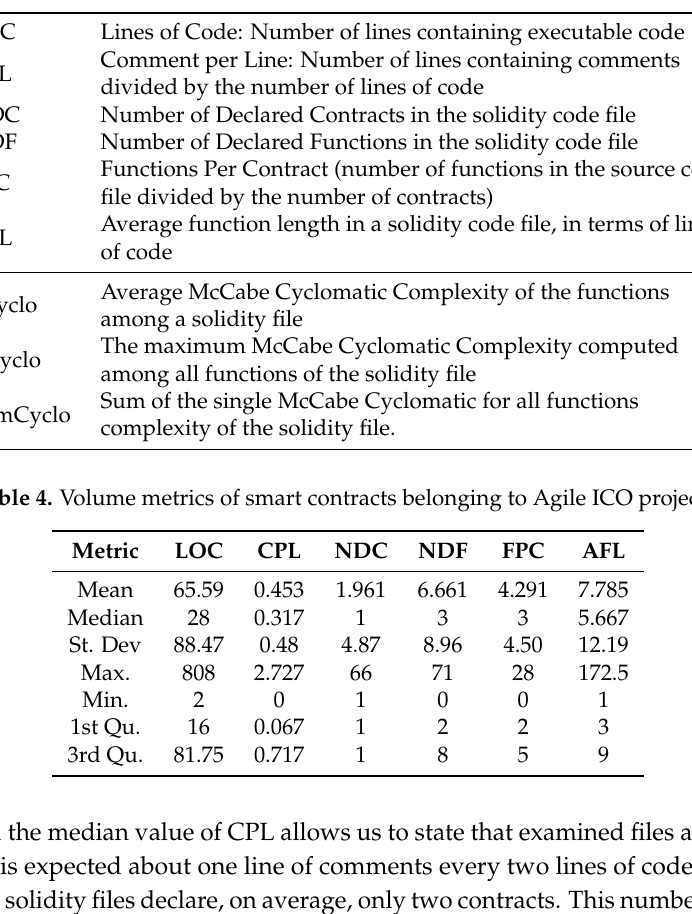
Table 3. Definition of computed source code metrics.